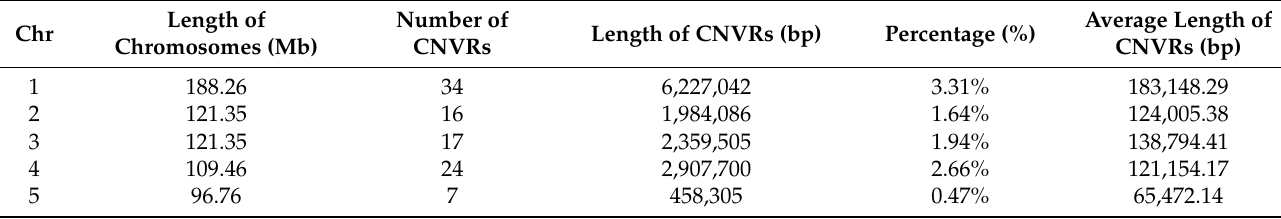
Table 4. Descriptive statistics of CNVRs on equine